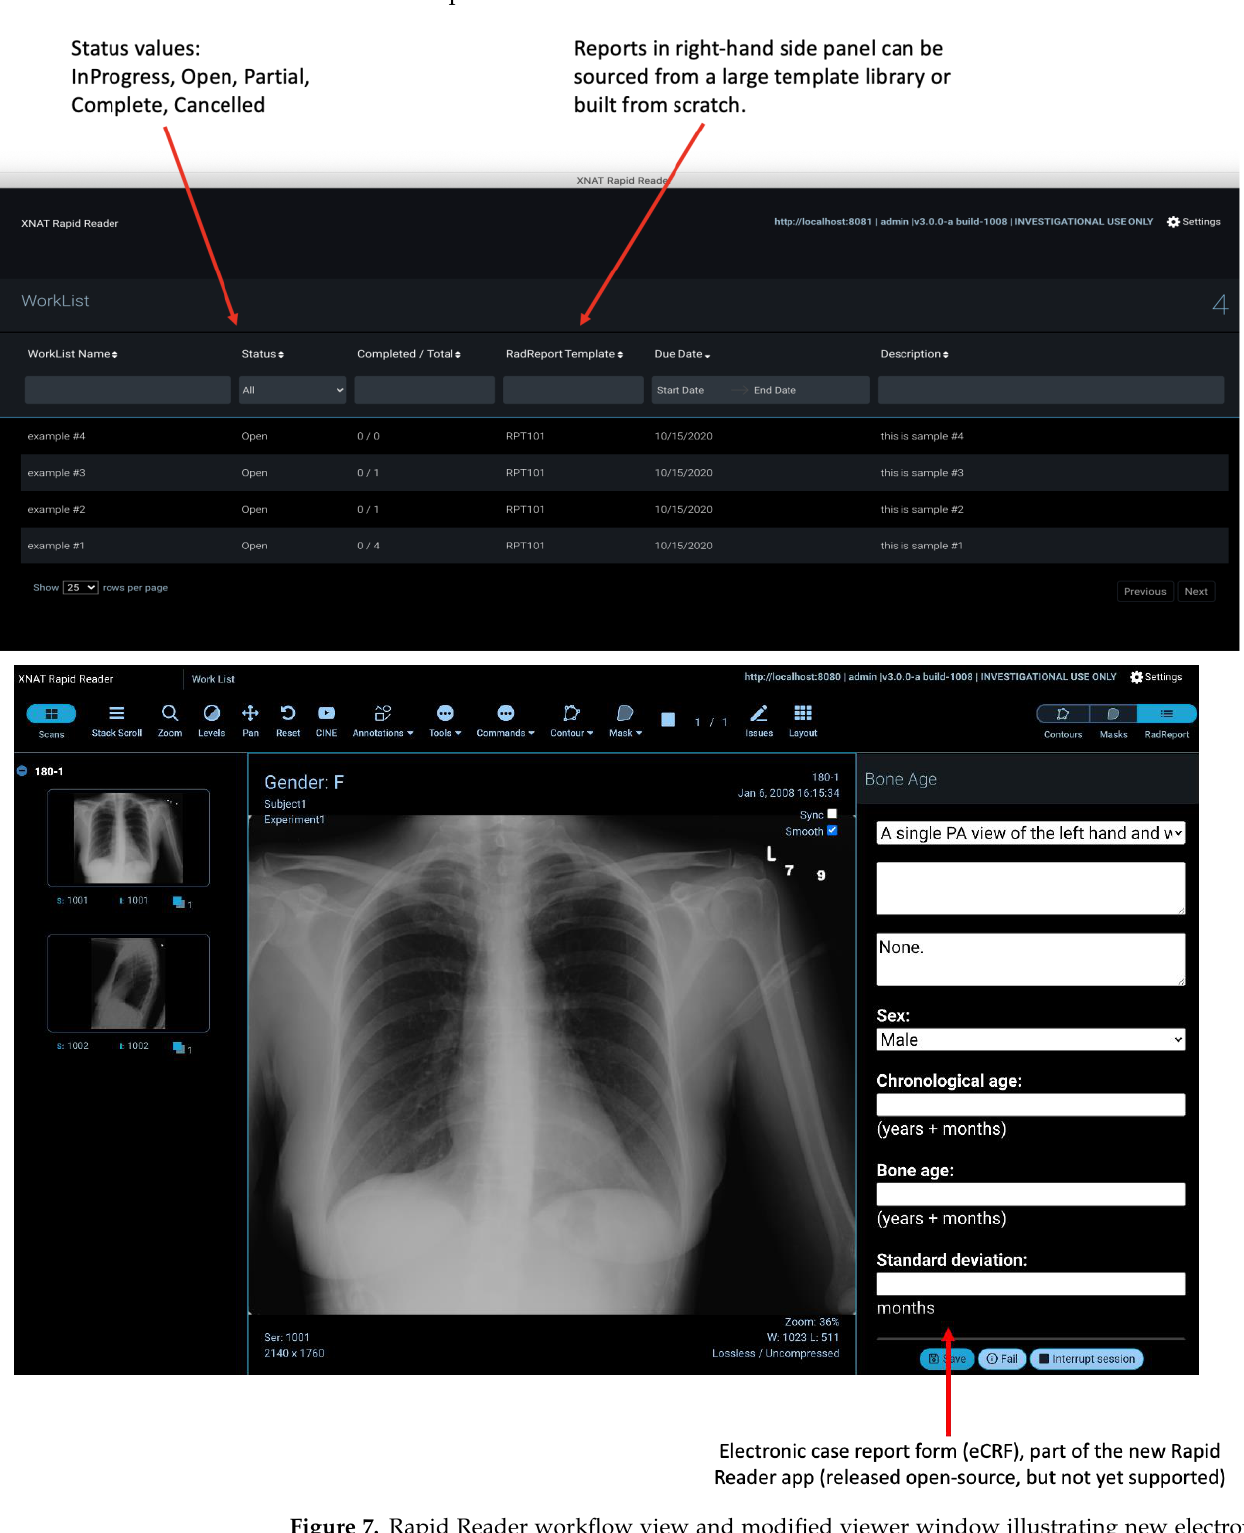
Figure 7. Rapid Reader workflow view and modified viewer window illustrating new electronic case report form (eCRF) panel used to render a RadReport template. Note the additional navigation and report controls on the right-hand side of the toolbar. Rapid Reader is currently in development: source code is available on request, but not yet supported by the XNAT team.